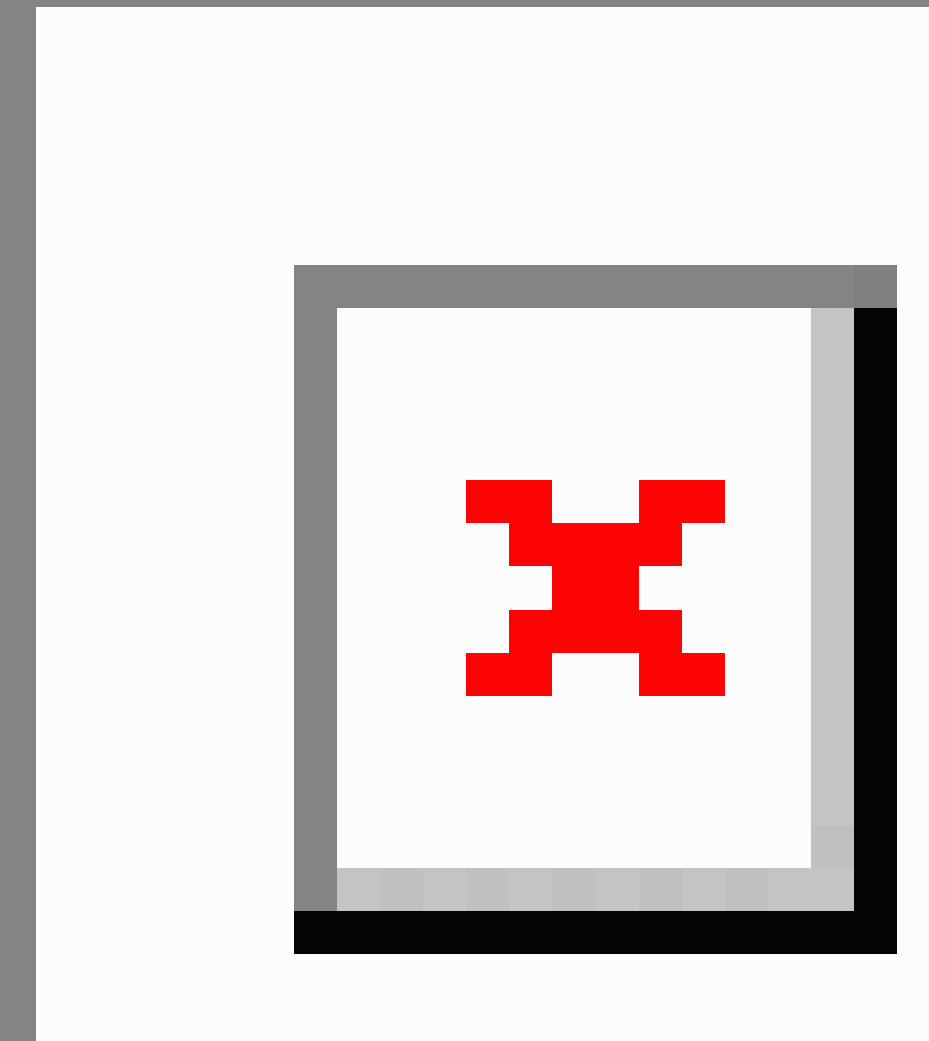
Figure 2. Steps to create a new